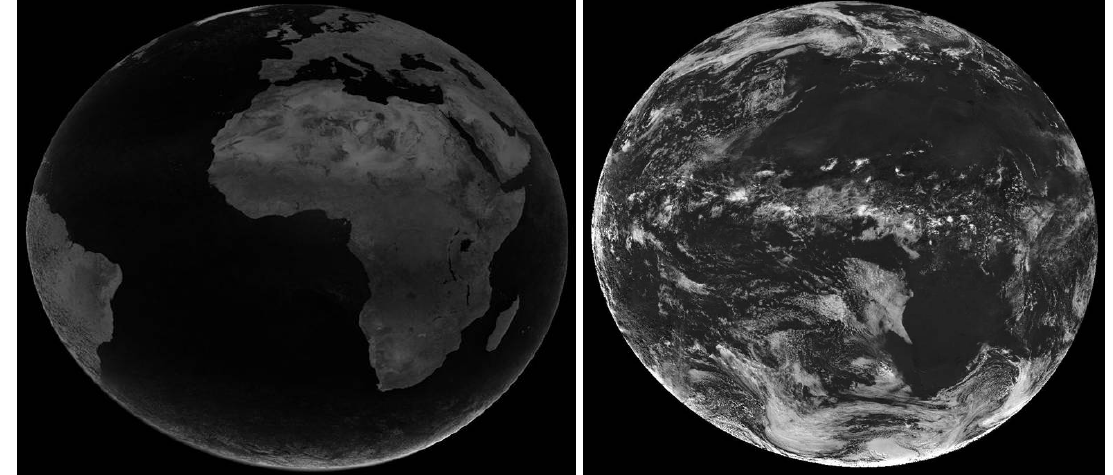
image and and effective cloud albedo for a 11 UTC slot in June